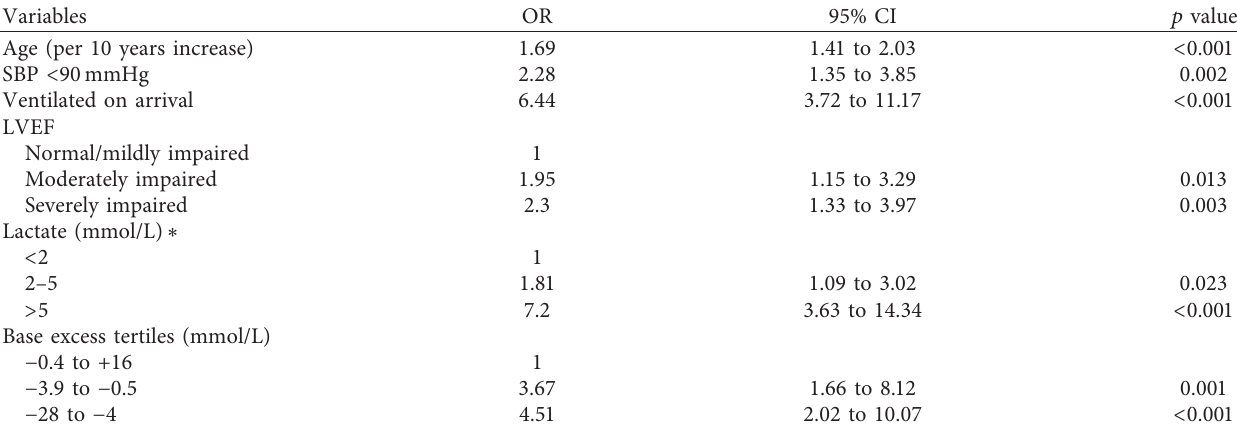
Table 1: Independent predictors (categorised) of 30-day mortality.